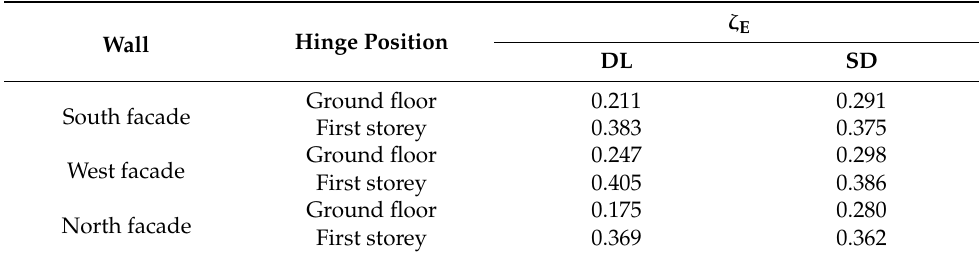
Table 4. Performance ratios ζ E at DL and SD limit states for single-unit model in as-built conditions according to kinematic